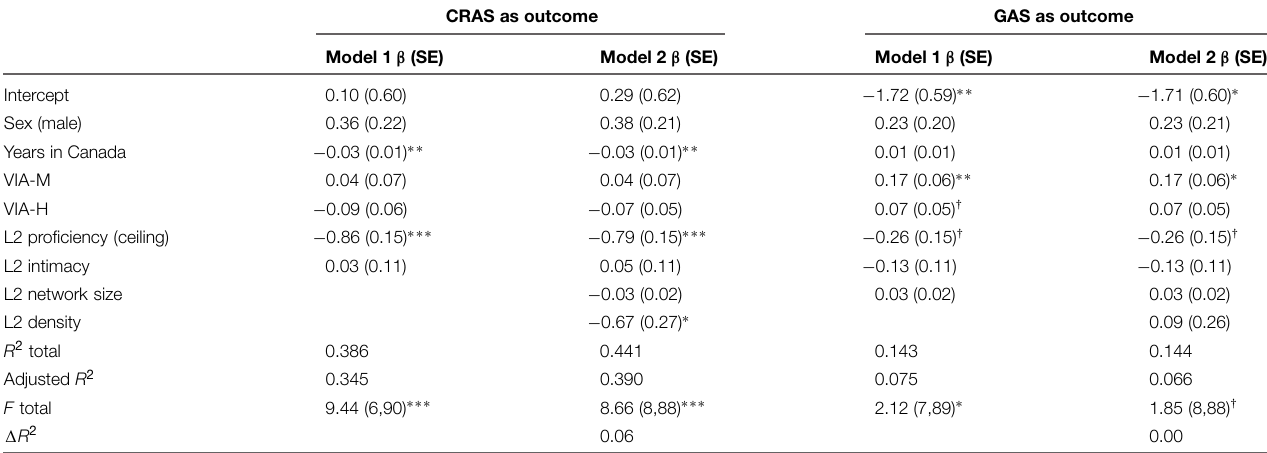
TABLE 3 | Multiple regression of CRAS and GAS with density as a measure of